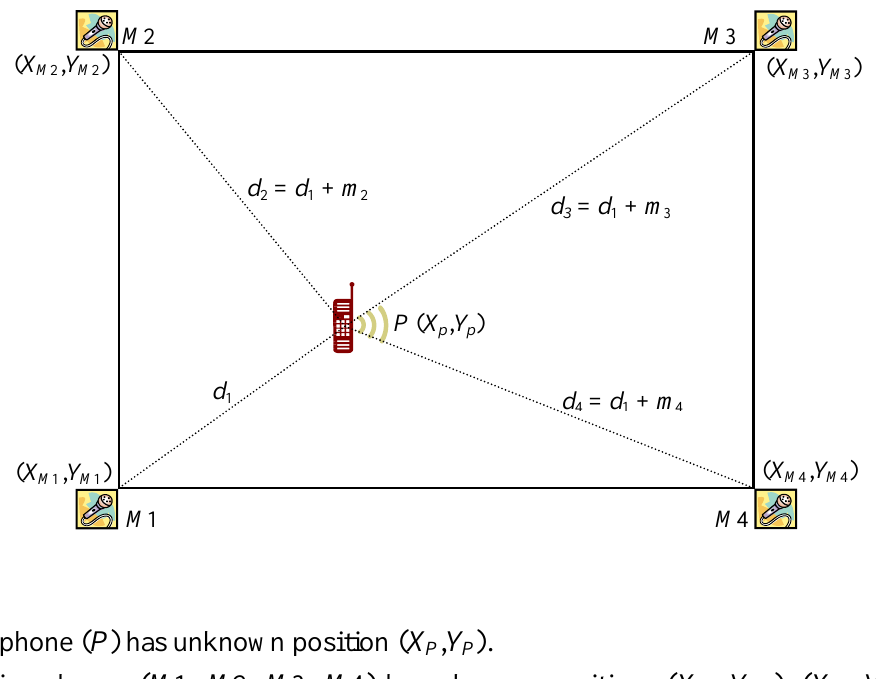
, d , d and d are unknown distances between the 1 2 3 4 , m and m 2 3 4